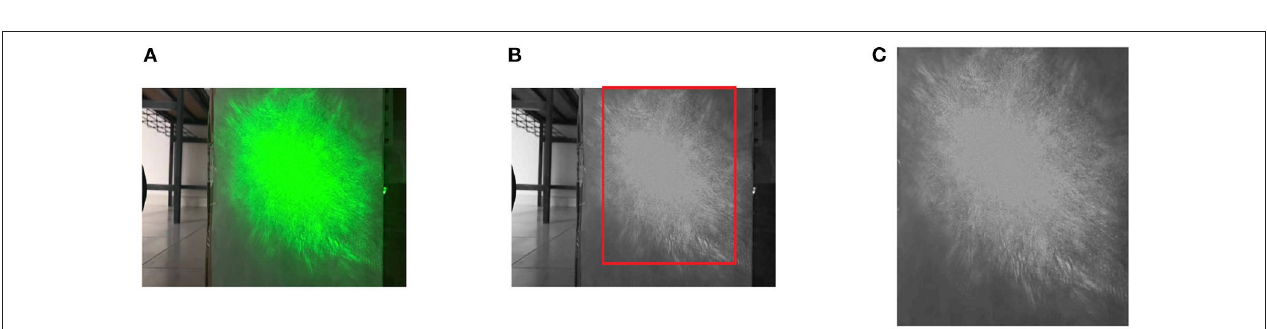
FIGURE 3 | Image processing: (A) Speckle reflection, (B) Gray-scale image, and (C) Region of interest.